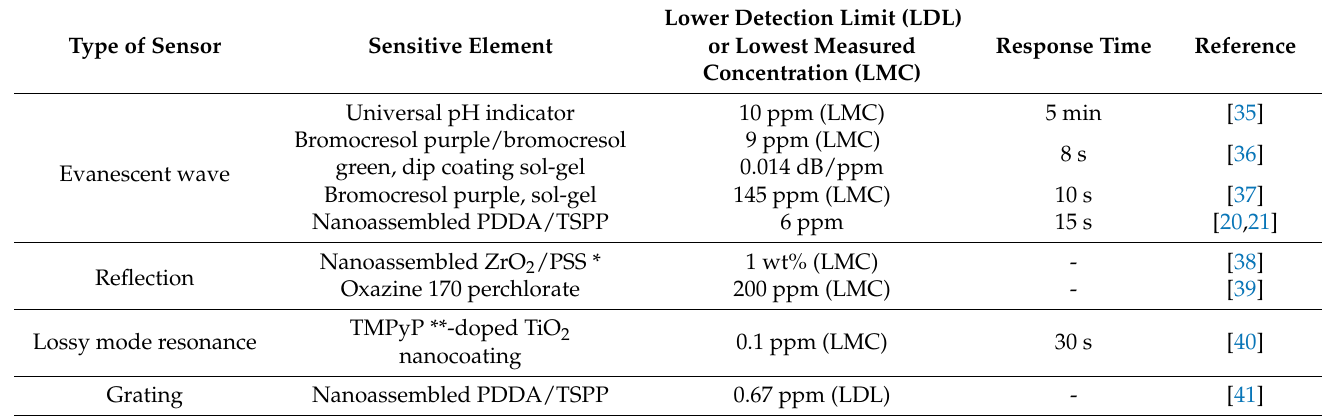
Table 1. A summary of optical sensing approaches for ammonia